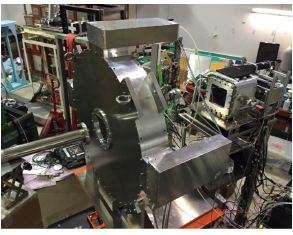
Figure 4. The construction of CDC was suc- cessfully completed.